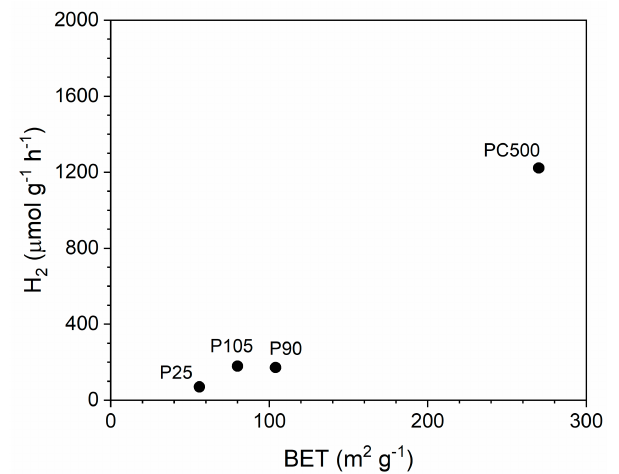
Figure 1. Hydrogen productivity as a function of the BET surface area for different commercial TiO 2 catalysts (c TiO = 0.56 g L − 1 , 300 W Xe lamp (full spectrum), and 10 vol.% 2